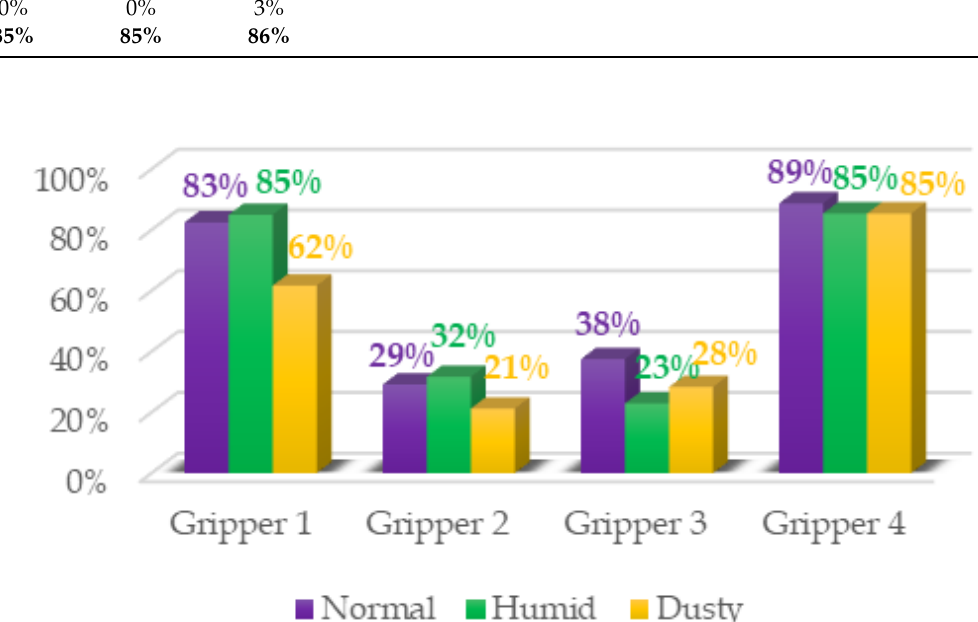
Figure 11. Summary of test results for the four grippers in the three